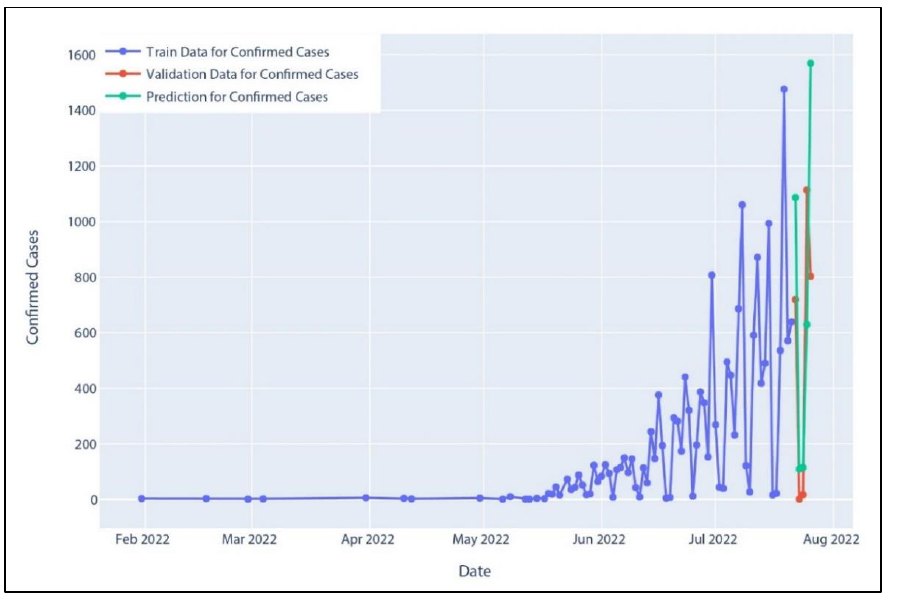
Figure 22. Confirmed cases of SARIMA model prediction. Table 8. SARIMA model confirmed case prediction over five days.